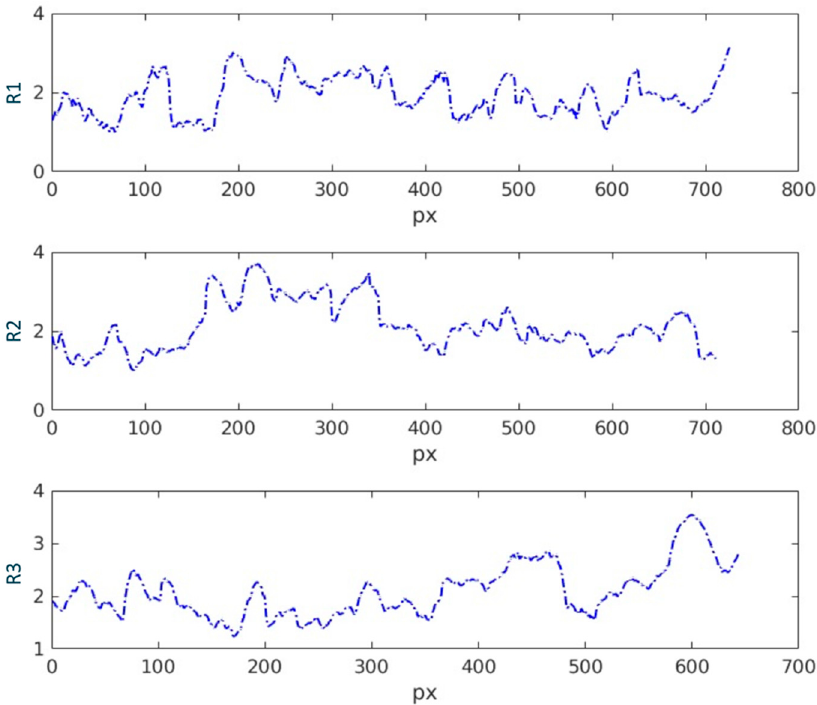
Figure 21. Roughness profiles R 1 , R 2 , and R 3 as a function of pixel number.